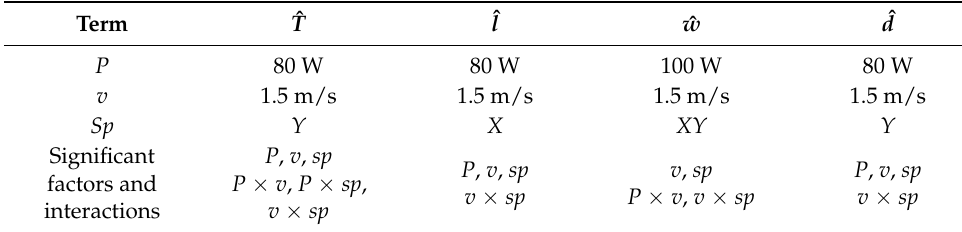
Table 7. Optimum factor level with significant factors and interactions. Term